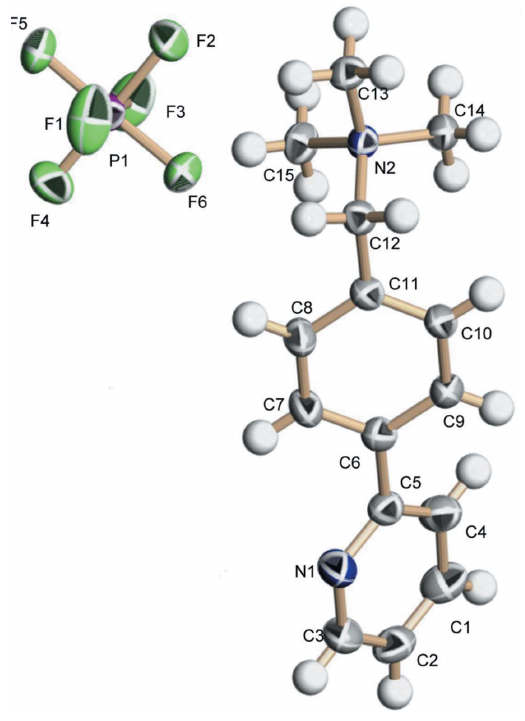
Figure 1 The molecular structure of the title compound showing 50% displace- ment